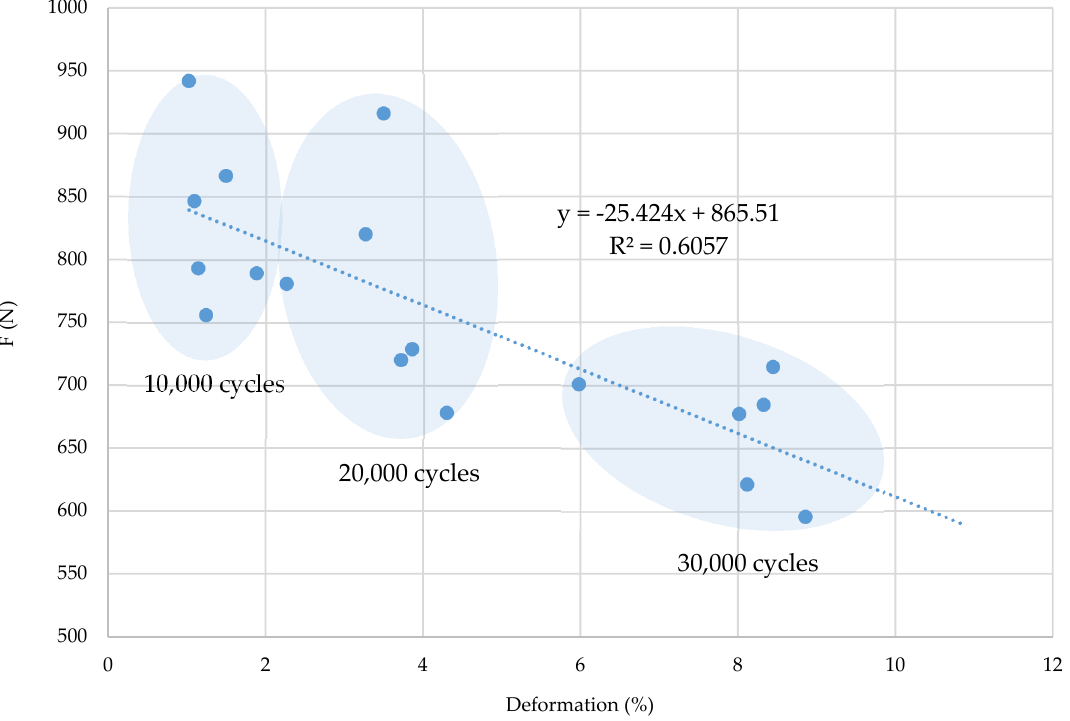
Figure 9. Correlation coefficient (of breaking forces and deformations), equation and regression line of samples in the weft direction.